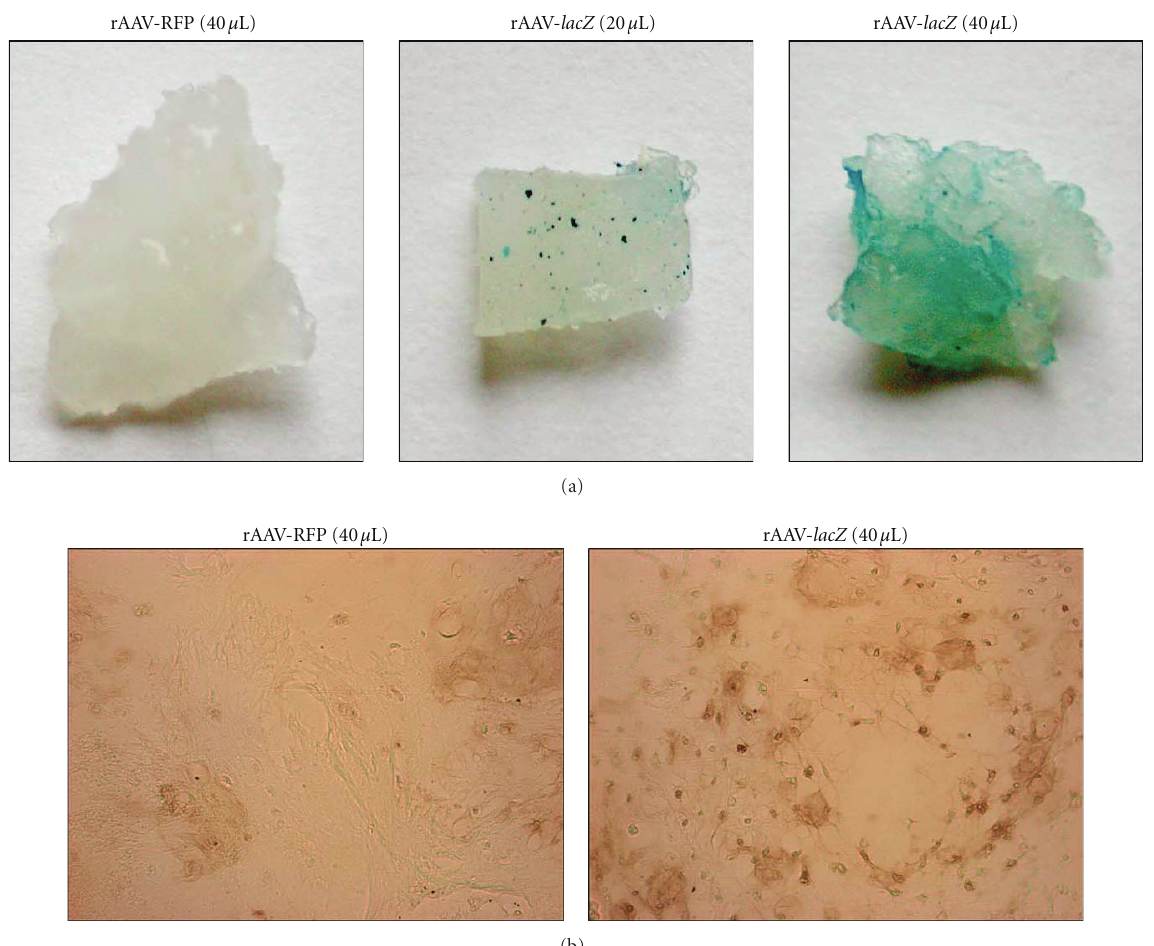
Figure 2: rAAV-mediated gene transfer in primary human chondrosarcoma in situ . Human chondrosarcoma explant cultures were transduced with rAAV-RFP or rAAV- lacZ (20 or 40 μ L) and processed to monitor transgene expression 20 days after vector application by X-Gal staining (a) and for immunodetection of β -gal activity ((b) magnification ×